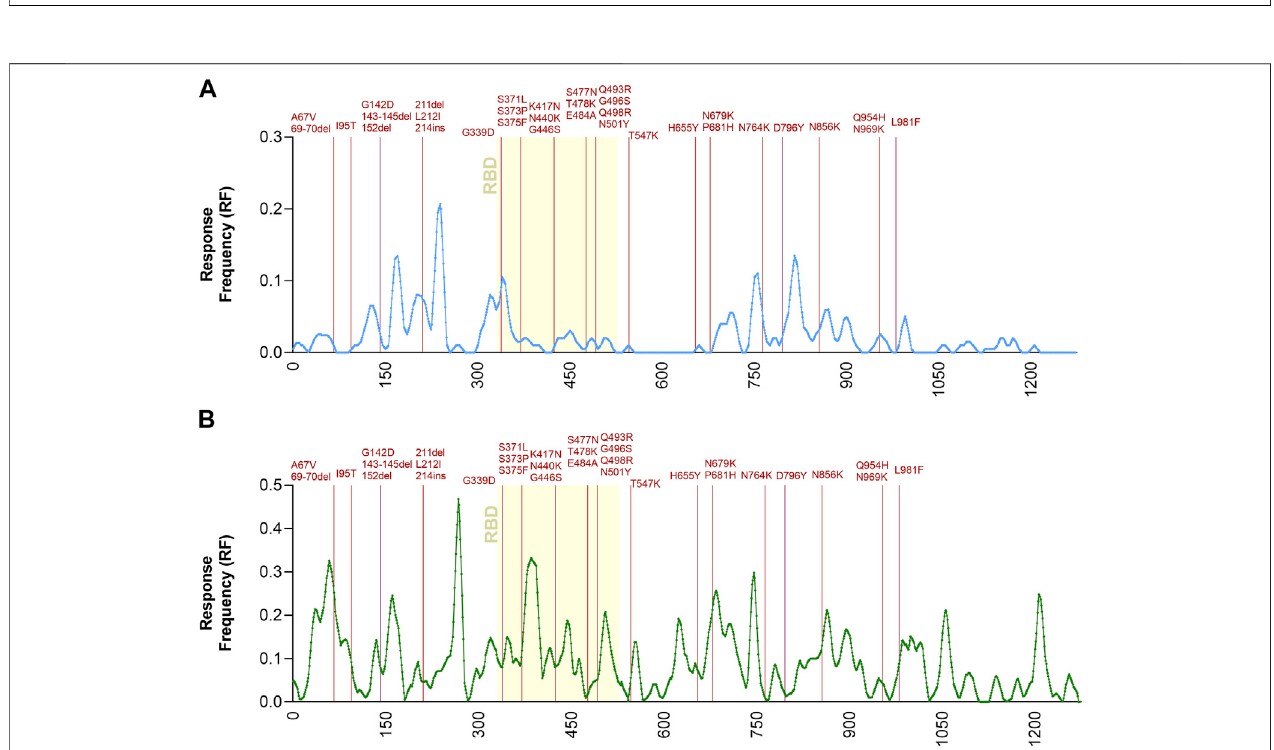
FIGURE 2 | Immunodominant antigenic regions impacted by Omicron mutations. Response Frequency de fi ned as the number of individuals and assays reporting positive responses to a peptide including that particular residue was calculated in a dataset previously reported (Grifoni et al., 2021). Only the spike protein was consideredforthisspeci fi canalysis.Panel (A) showsCD4(lightblue)whilepanel (B) showsCD8(green)Tcellepitopes.Thereceptorbindingdomain(RBD)regionofthe spike protein, is indicated in yellow because it is critically recognized by neutralizing antibodies and implicated in viral cell entry. The spike mutations found in Omicron related to the Ancestral sequences are noted in dark